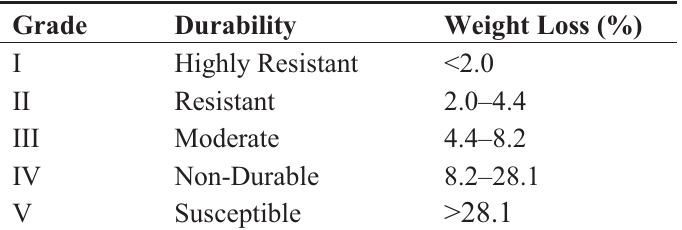
Table 1. Durability of wood sample based on weight loss